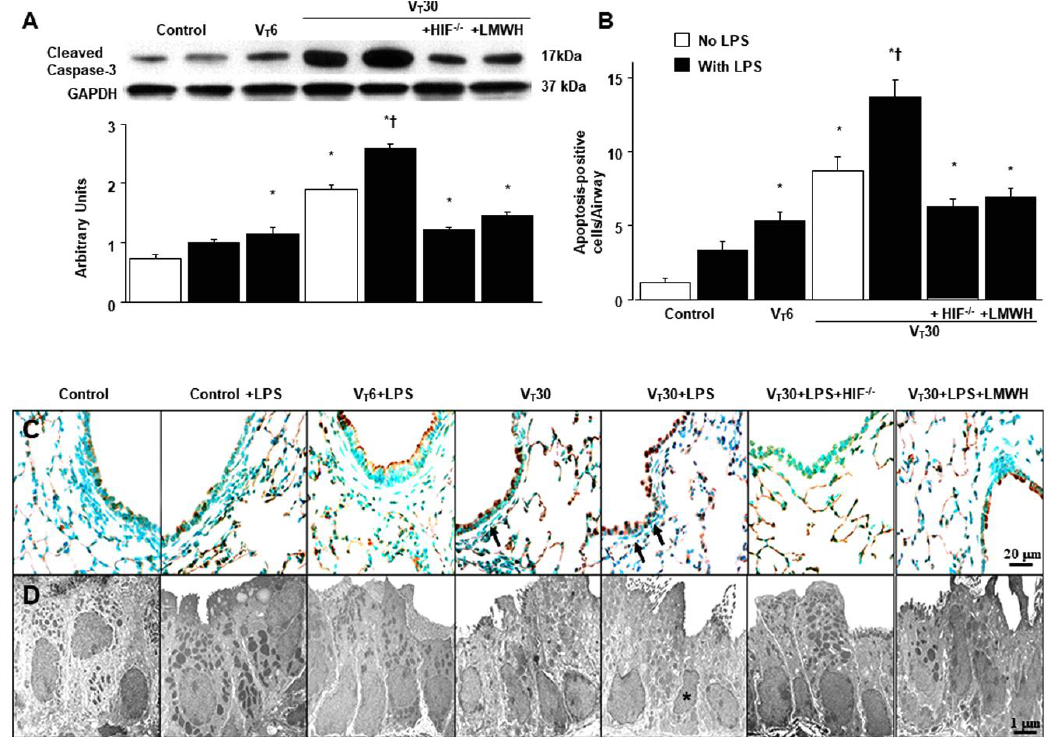
Figure 7. HIF-1 α homozygous knockout and enoxaparin ameliorated endotoxin-augmented mechanical ventilation-induced caspase-3 expression and epithelial apoptosis. ( A ) Western blots from the same animals were conducted using antibodies that recognize caspase-3 and GAPDH expression from the lungs of nonventilated control mice and mice ventilated at a tidal volume of 6 or 30 mL / kg for 5 h with or without LPS administration ( n = 5 per group). Arbitrary units were expressed as the ratio of cleaved caspase-3 to GAPDH ( n = 5 per group). ( B – D ) Representative micrographs with TUNEL staining of para ffi n lung sections and quantitation ( B , C , 400 × ) ( n = 5 per group) and transmission electron microscopic image ( D , 10,000 × ) (n = 3 per group) were from the nonventilated control mice and those subjected to a tidal volume of 6 or 30 mL / kg for 5 h with or without LPS administration. A dark-brown diaminobenzidine signal indicated positive staining of apoptotic cells, whereas shades of blue–green to greenish tan signified nonreactive cells. Highly condensed and fragmented heterochromatin of epithelial cells indicates apoptosis. Apoptotic cells are identified by asterisks or arrows. Enoxaparin, 4 mg / kg, was given subcutaneously 30 min before mechanical ventilation. * p < 0.05 versus the nonventilated control mice with LPS; † p < 0.05 versus all other groups. Scale bars represent 20 µ m (TUNEL) or 1 µ m (TEM). TEM = transmission electron microscopy; TUNEL = terminal deoxynucleotidyl transferase-mediated dUTP-biotin nick end-labeling.